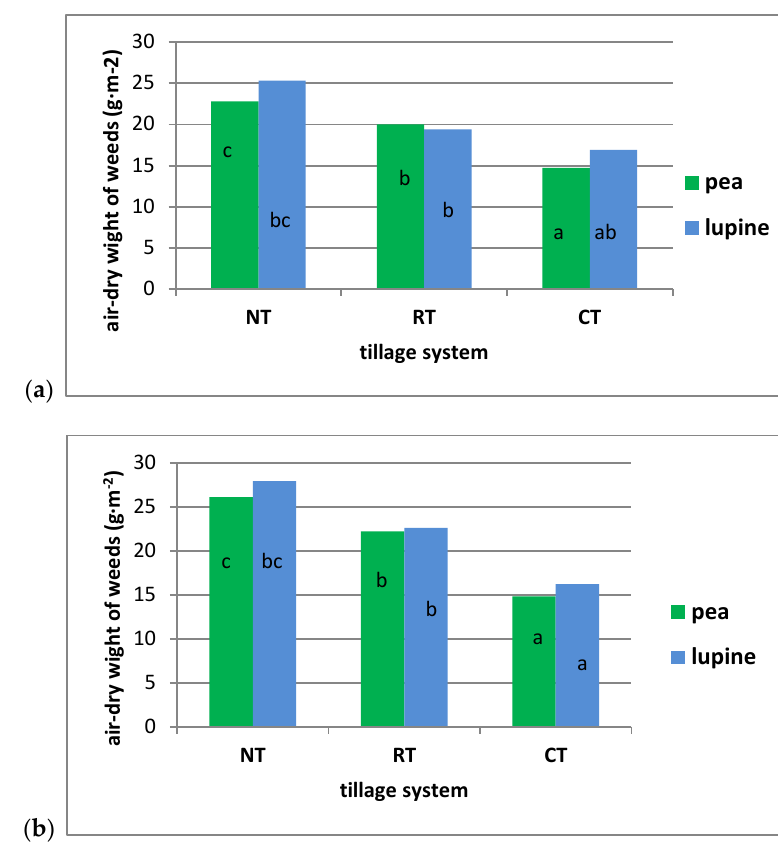
Figure 2. Average (for the years of research) air-dry weight of weeds (g·m −2 ) in different tillage system in term: ( a ) flowering stage and ( b ) before harvest. NT—no-tillage, RT—reduced tillage, CT—plough tillage.